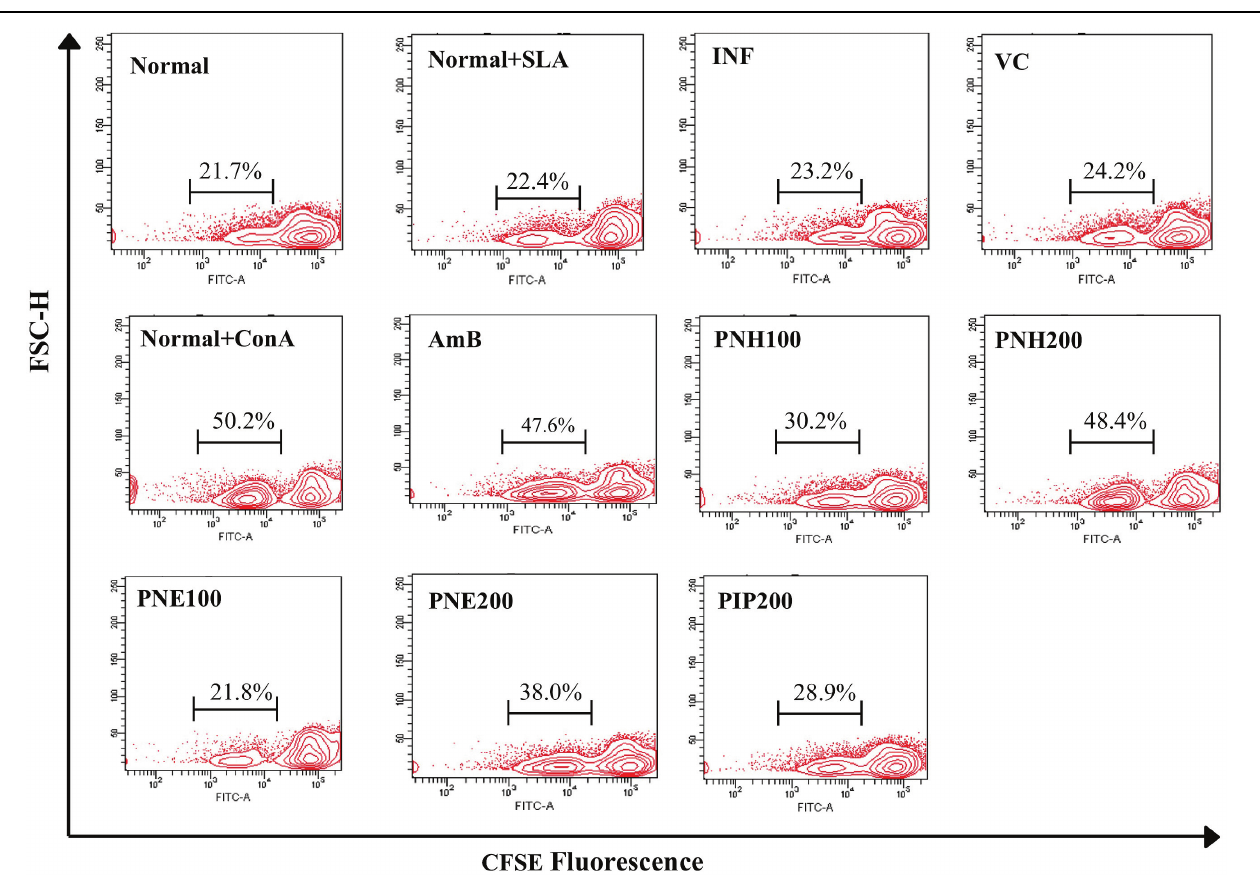
FIGURE 6 | Assessment of lymphoproliferative responses in L. donovani infected BALB/c mice. Post 2 weeks treatment, RBCs free single cell suspension of splenocytes was labeled with CFSE and in vitro restimulated with SLA. The contour plots depict CFSE fluorescence where a shift in MFI toward left denotes loss of CFSE labeling and in turn, lymphoproliferation. Percentage of CFSE positive cells in respective samples in the presence or absence of SLA stimulation is indicated.